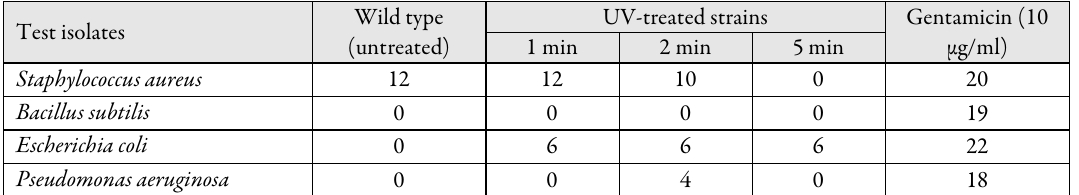
Table 1. Antibacterial inhibition zones diameters (mm) obtained from the extracts of wild type and